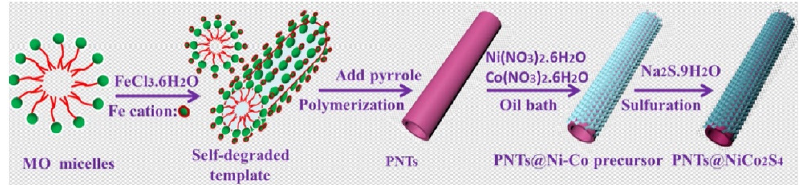
Figure 15. Schematic illustration of polyporrole nanotubes@NiCo 2 S 4 core-shell formation. Repro- duced with permission from Jun Zhang, Hierarchical polypyrrole nanotubes@NiCo 2 S 4 nanosheets core-shell composites with improved electrochemical performance as supercapacitors; published by Elsevier, 2017 [144] .